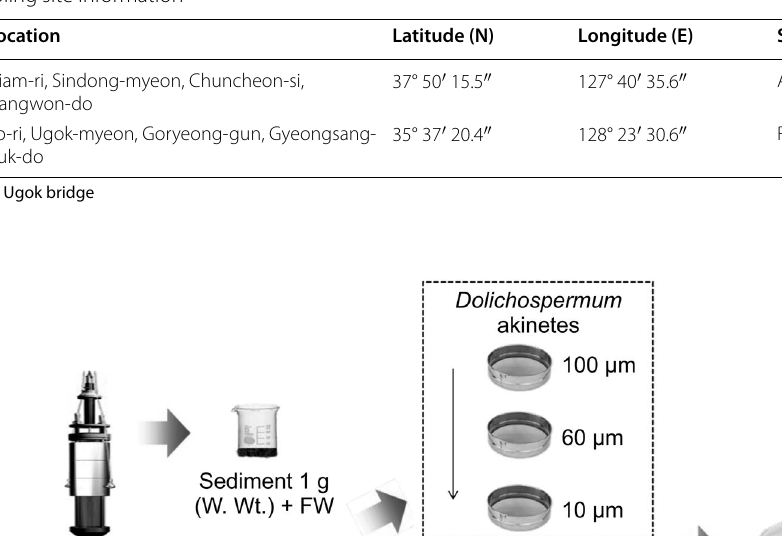
Table 1 Sampling site information